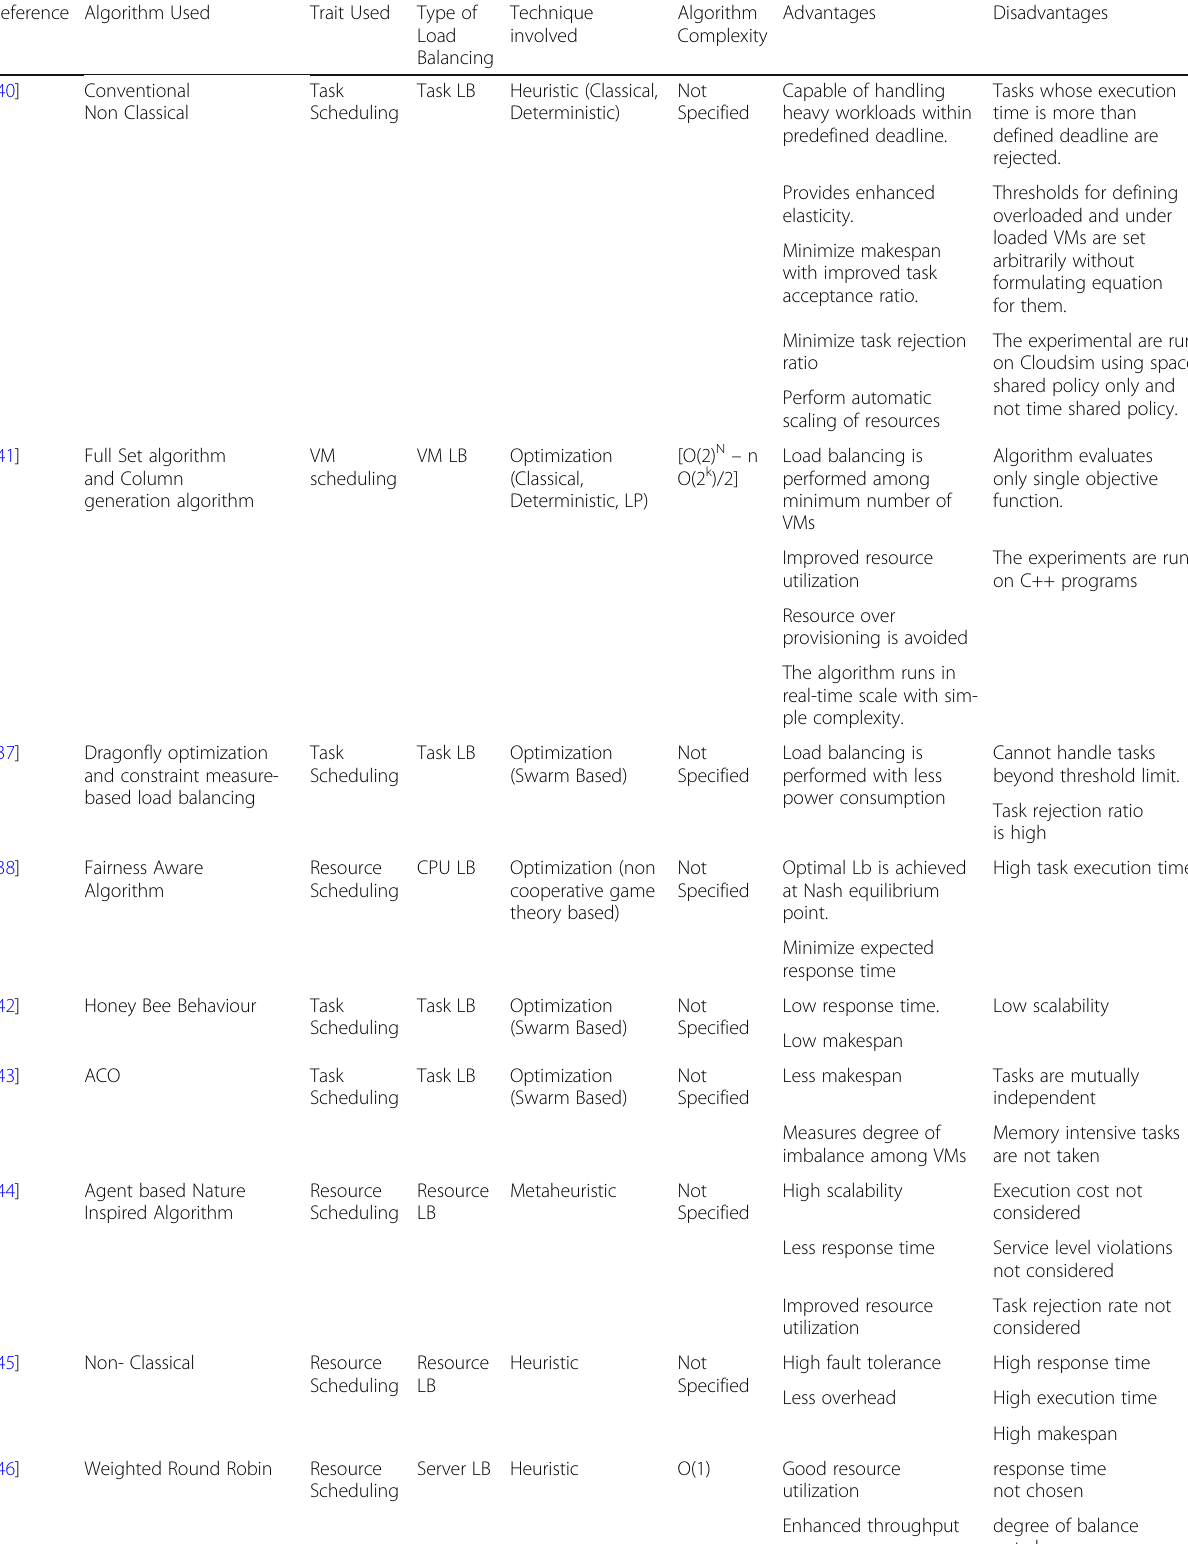
Table 1 Proactive approaches of Cloud load balancing in existing literature Reference Algorithm